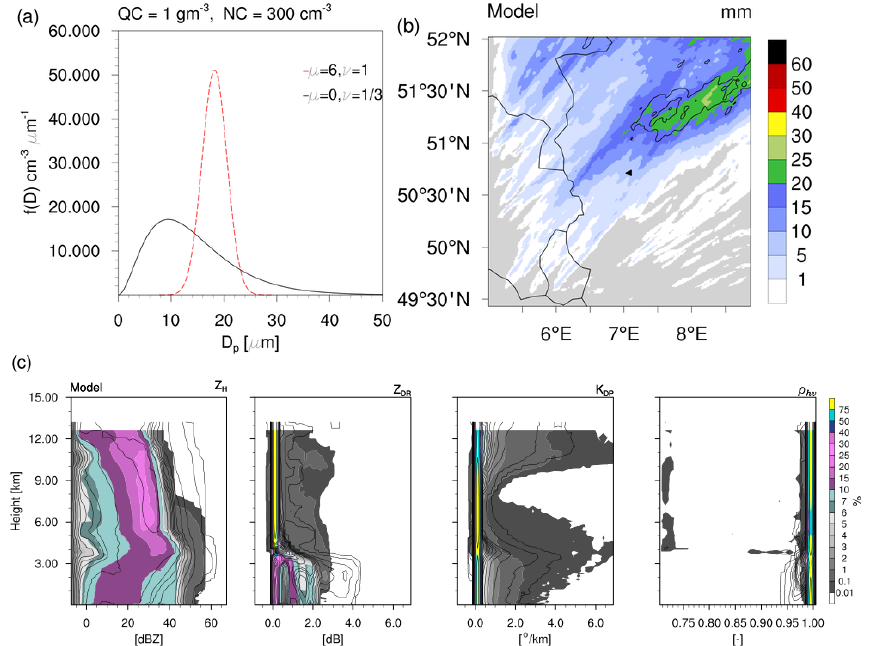
Figure 12. (a) Modified gamma particle size distribution as a function of particle diameter ( D p ) for the default and narrow cloud drop size distribution (CDSD). The bulk number concentration and mass density is 300cm − 3 and 1gm − 3 , respectively. (b) Spatial pattern of ensemble-averaged accumulated precipitation for the default and narrow CDSD (solid contour lines with intervals at 20, 30 and 35mm). (c) CFADs of horizontal reflectivity and differential reflectivity, specifically the differential phase and cross-correlation coefficient from 14:45 to 15:30UTC on 5 July 2015. CFADs are shown for five ensemble members for narrow CDSD. The CFADs of the default experiment are shown in black contoured lines only.